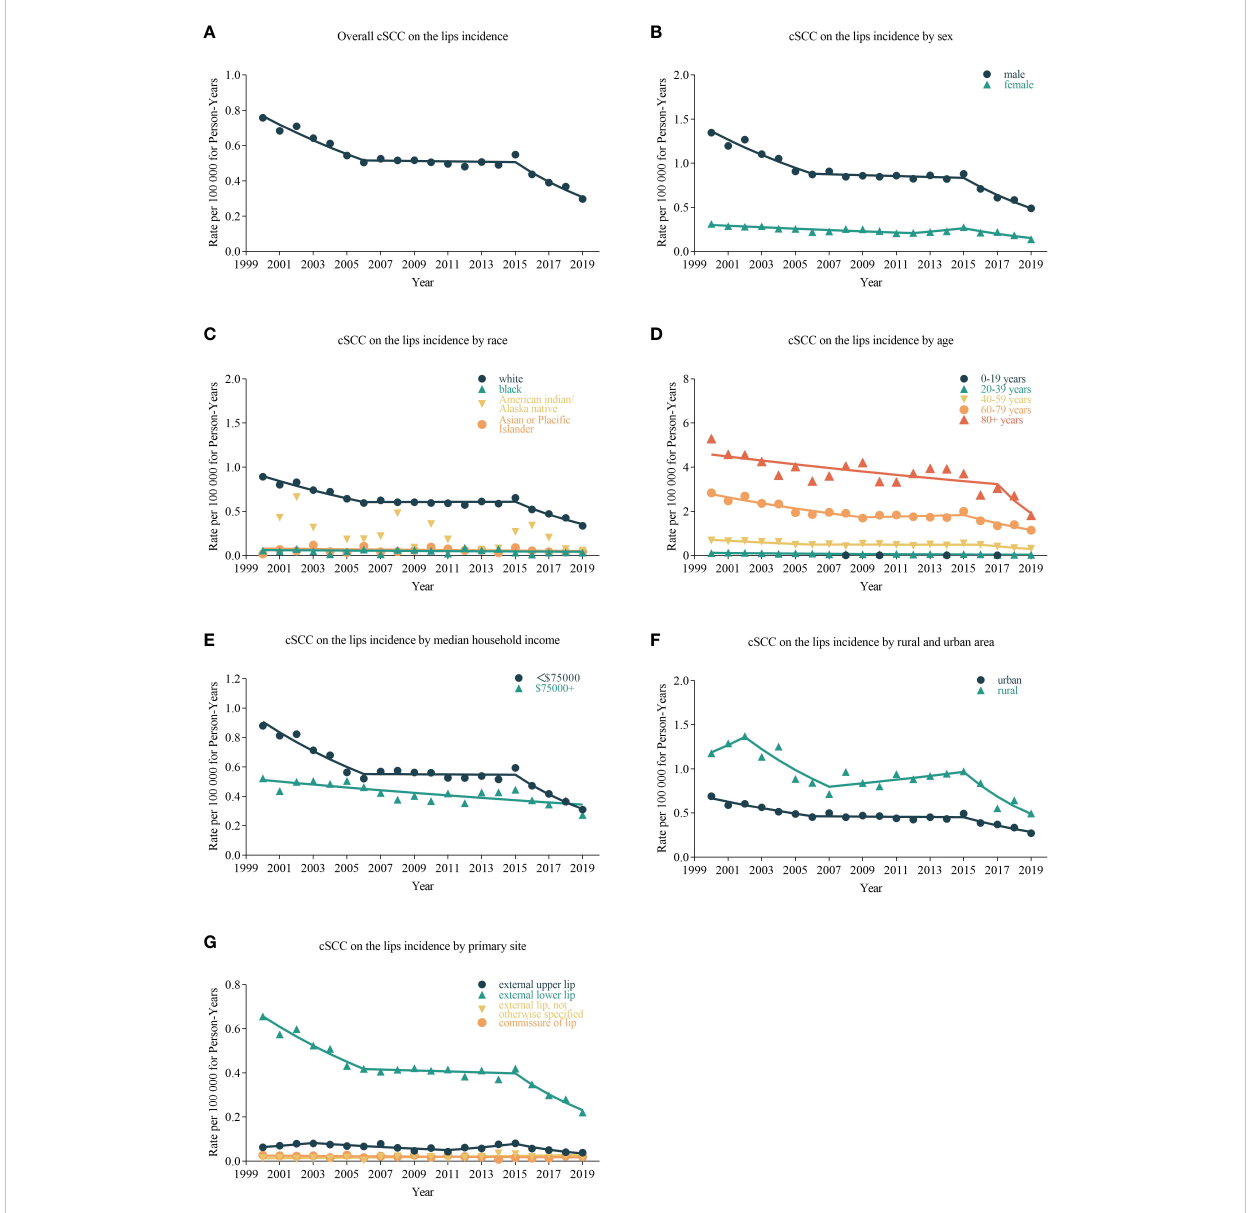
FIGURE 1 Trends in annual cSCC on the lip incidence rates. Data markers delegate observed incidence rates (per 100,000 person-years). The slope of the line indicates the annual percentage change (APC). (A) The overall incidence and trend of cSCC on the lips patients; the line graphs are classi fi ed into different groups, including sex (B) , race (C) , age (D) , median household income (E) , urban and rural area (F) , and primary site (G)